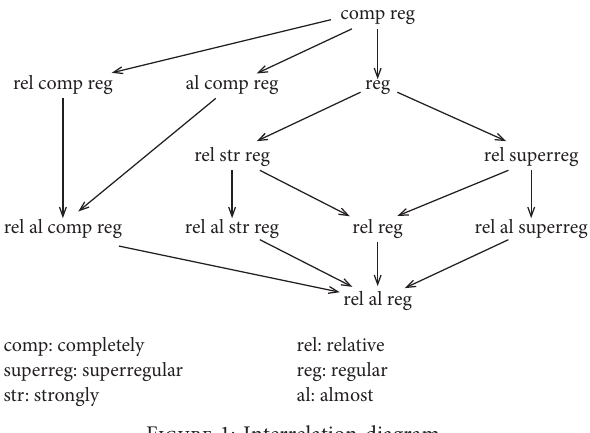
Figure 1: Interrelation